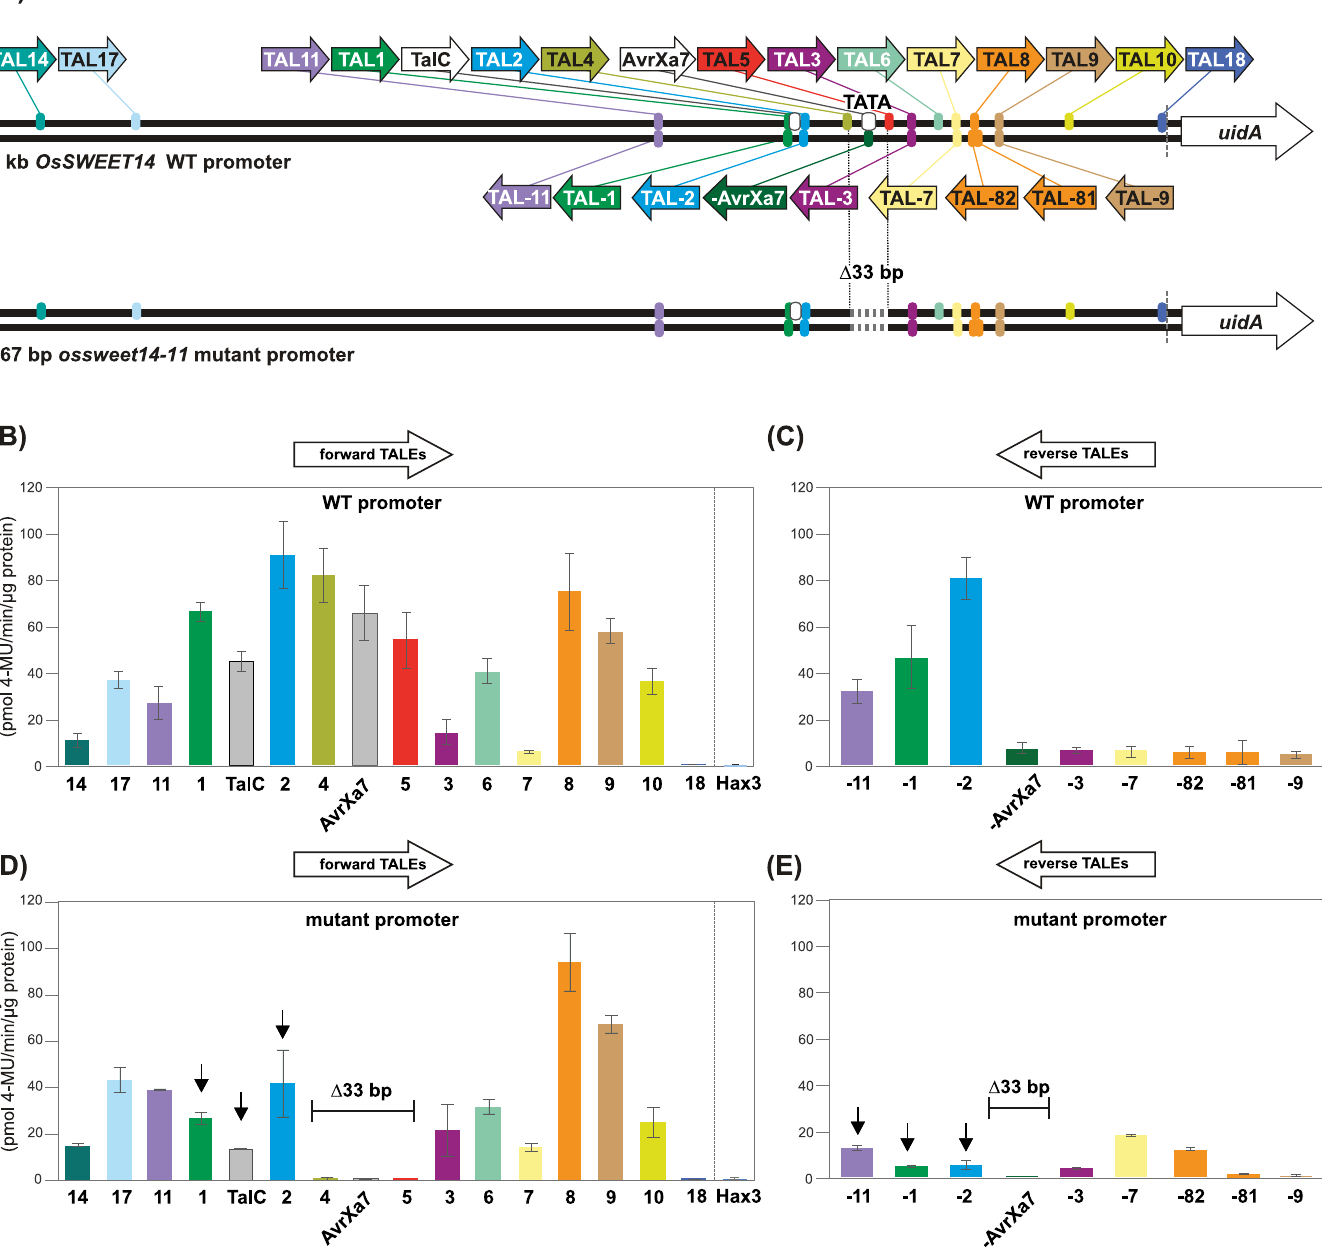
Fig 3. TALEs enhance transcription from diverse positions in the rice OsSWEET14 promoter in N . benthamiana in a partially TATA- box dependent manner. ( A ) Overview of the reporter construct containing the OsSWEET14 wildtype(WT) promoter fragment (1kb upstream of the ATG) and the OsSWEET14-11 promotermutant ( Δ 33 bp; 967 bp upstream of the ATG; [41]) fused to the promoterless uidA reporter gene. The dashed line indicatesthe location of the attB1 site preceding the uidA reporter gene. The bindingsites and bindingorientationsof artificial TALEs (coloured) and the natural TALEs TalC and AvrXa7 (white) are marked with arrows, the arrowheadindicatesthe orientationof the activationdomain relativeto the uidA gene. Reverse bindingTALEs are labeledwith "-" in front of the number. RVD sequencesand target sites are listed in S1 Table. (B)-(E) Activity of the artificial and natural TALEs. Agrobacterium strains deliveringTALE constructs under control of the 35S promoterwere co-inoculated into N . benthamiana leaves along with an Agrobacterium strain deliveringthe reporter construct. The TALE Hax3 that does not bind to the OsSWEET14 promoterwas used as negative control to exclude background promoteractivity. The ß-glucuronidasemeasurement was performed 2 dpi. Error bars represent the standarddeviationof three independent replicates(4-MU, 4-methyl-umbelliferone). ( B ) Activity of forward TALEs in combination with the WT reporter. ( C ) Activity of reverse TALEs in combination with the WT reporter. ( D ) Activity of forward TALEs in combination with the mutant reporter. ( E ) Activity of reverse TALEs in combination with the mutant reporter. (D, E) TALEs whose bindingsites overlap with the deletionin the mutant promoterare indicatedwith Δ 33 bp. Arrows highlight a strong reduction of TALE activity in comparison to the WT